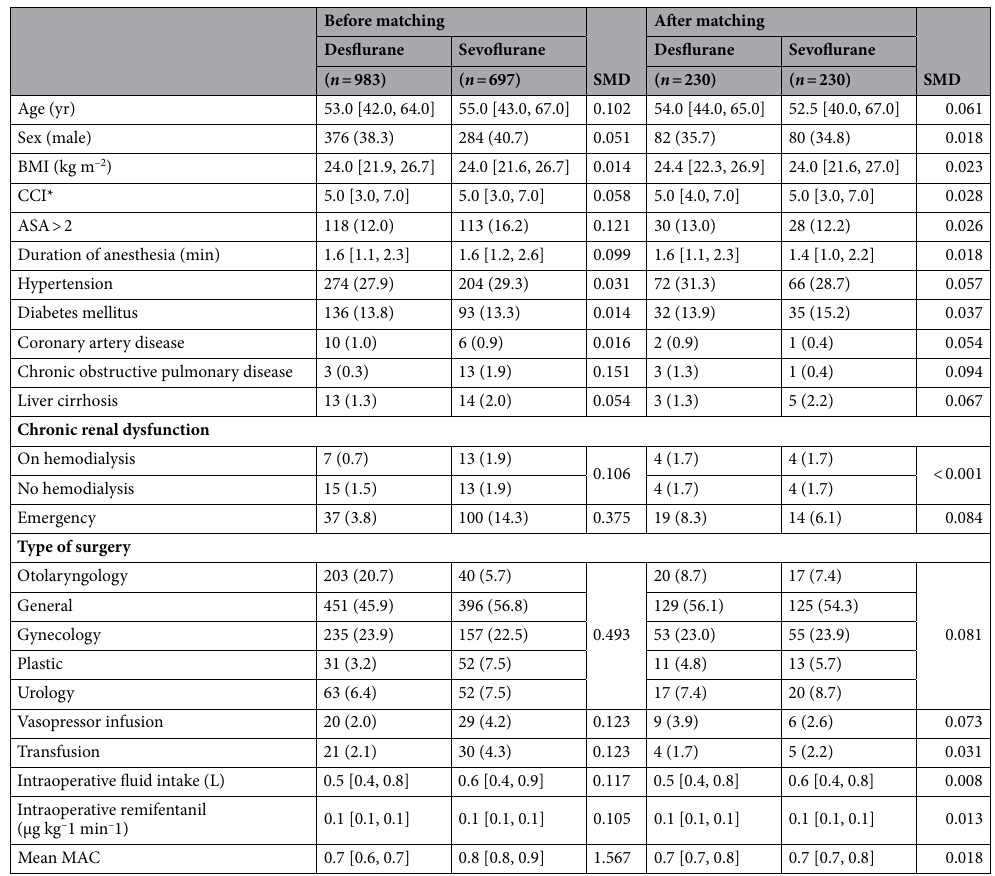
Table 1. Clinical characteristics before and after propensity score matching. SMD standardized mean difference, BMI body mass index, CCI Charlson comorbidity index, ASA American Society